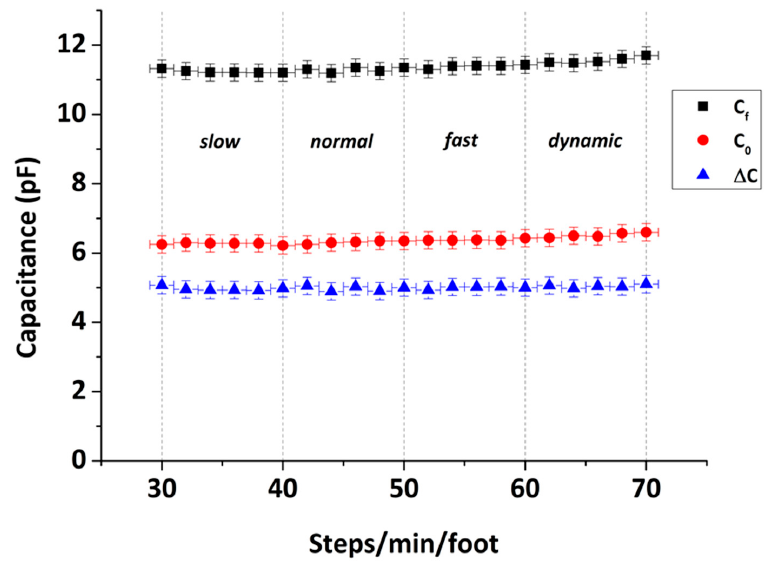
Figure 7. Capacitance response of a typical 3D-printed capacitive pressure sensor at different gait speeds (30 − 70 steps/min) under an applied pressure of 872.4 kPa ; C (cid:2868) — initial value, C (cid:2916) — final speeds (30–70 steps/min) under an applied pressure of 872.4 kPa; C 0 ¯ initial value, C f ¯ final value value and ΔC (cid:3404) C (cid:2916) − C (cid:2868) . and ∆ C = C f − C 0